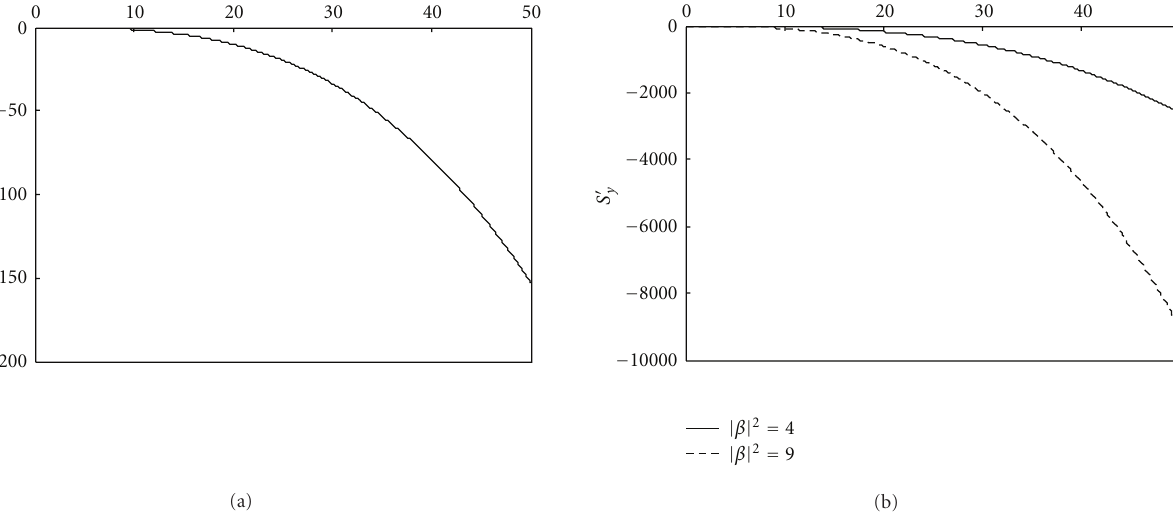
with | α | 2 and | β | 2 in stimulated six-wave y